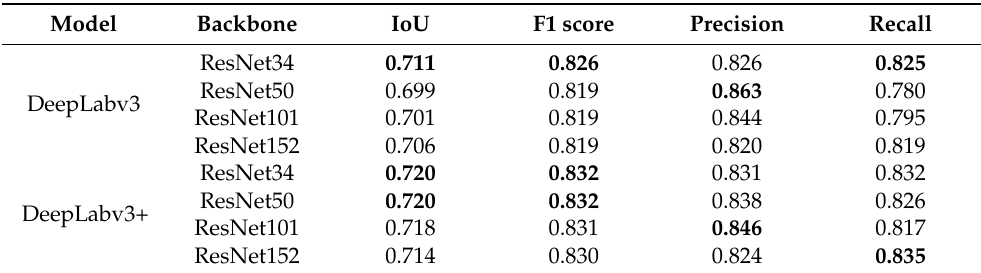
Table 5. Performance of DeepLabv3 and DeepLabv3+ for different